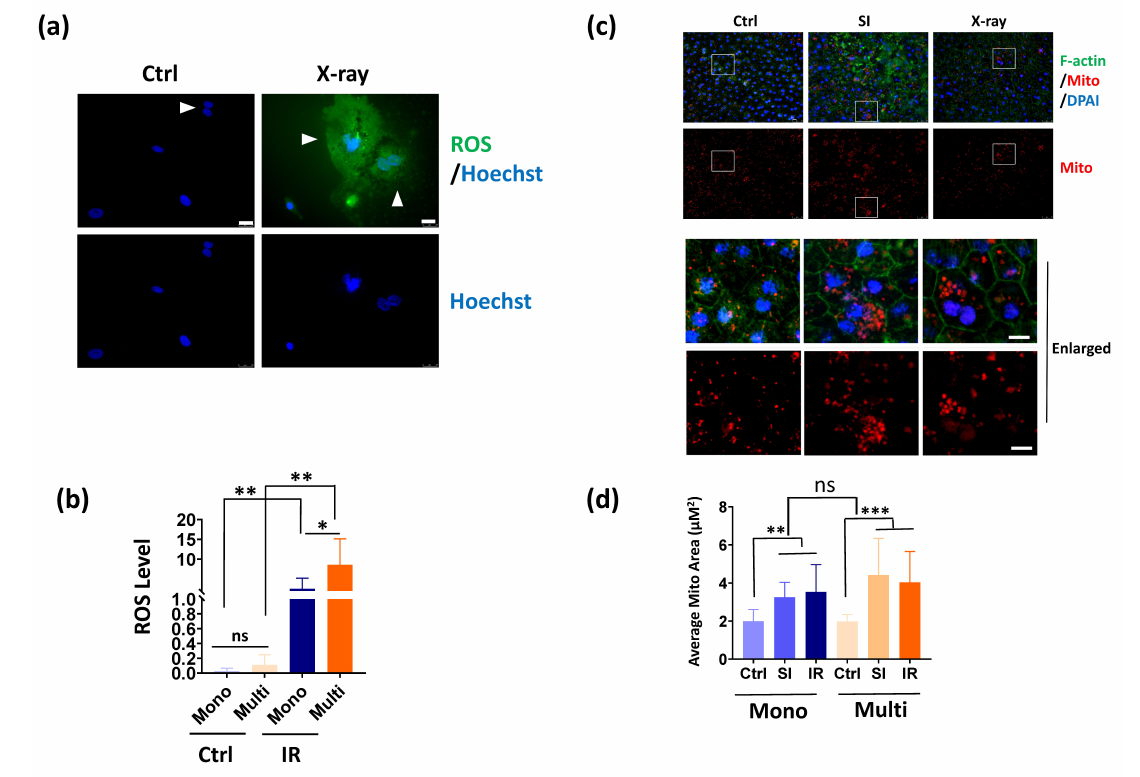
Figure 4. Multinucleated RPE cells generate more ROS than mononucleated RPE cells. Multinucleate mouse RPE cells exhibited increased ROS production than mononucleate cells after IR exposure. The primary mouse RPE cells were untreated (Ctrl) or exposed to 1 Gy of IR. After recovery in growth medium for 4 h, the ROS levels were detected and the nuclei were counterstained by Hoechst. Arrowheads indicate multinucleated RPE cells. ( b ) Quantitative results of ROS as indicated in ( a ). The green fluorescence intensity was quantified by Image J. For each group, about 15 cells were quantified. *: p < 0.05, ns: not significant. ( c ) Mitochondria morphology in mouse RPE whole mount with or without sodium iodate (SI) or IR exposure. The F-actin was labeled by FITC-phalloidin and the mitochondria were labeled by Mitotracker red. The nuclei were stained by DAPI. Scale bar: upper panels: 25 µ M, lower upper panels: 10 µ M. ( d ) Quantification results of mitochondria average area in mononucleated and multinucleated RPE cells. n = 15 cells per group. **: p < 0.01, ***: p < 0.001, ns: not significant. All data are shown as mean ±